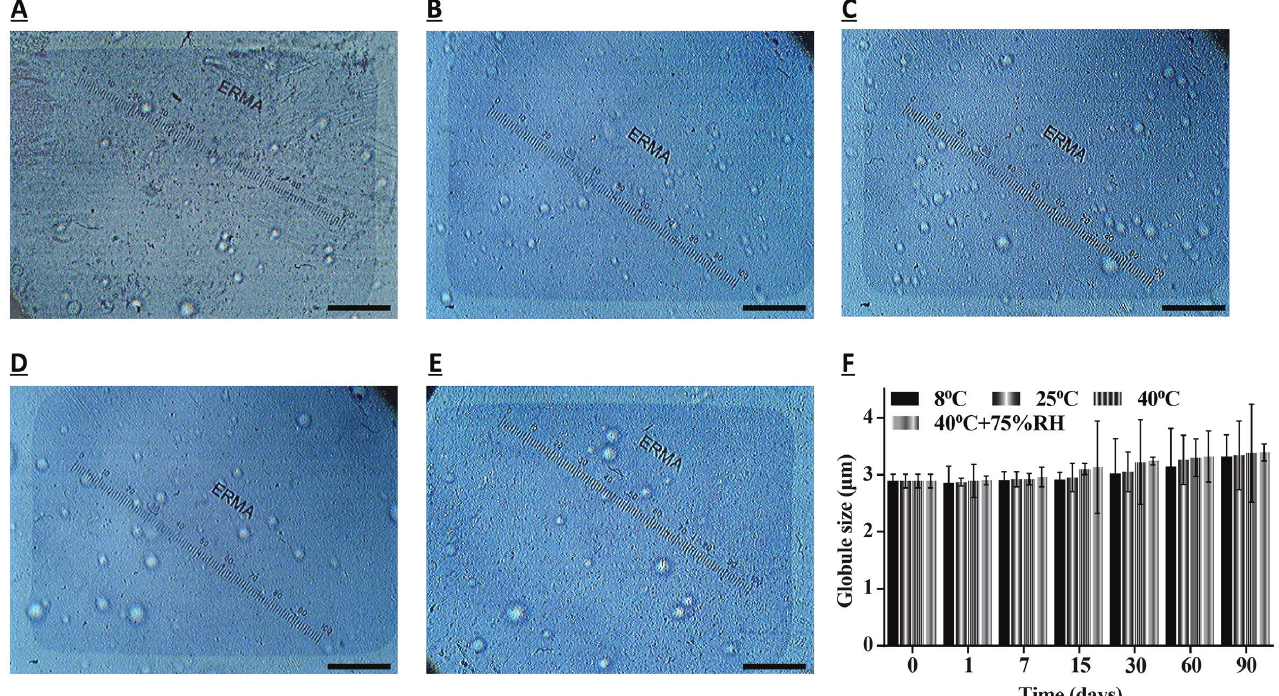
FIGURE 2 - Microscopic images of freshly prepared CT emulgel and samples placed at different storage conditions, (A) freshly prepared CT emulgel, (B) 8 °C after 90-days, (C) 25 °C after 90-days, (D) 40 °C after 90-days, (E) 40 °C±75% RH after 90 days, F variation globule size at different storage conditions, scale bar = 100